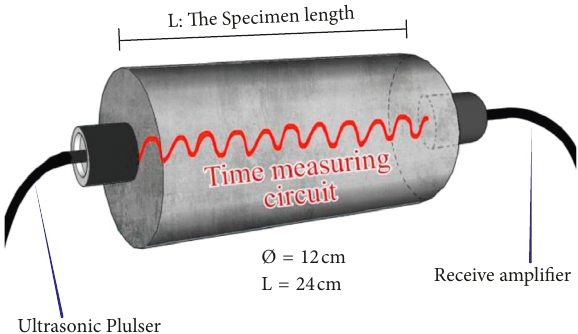
Figure 5: Model of schematic diagram of pulse velocity testing